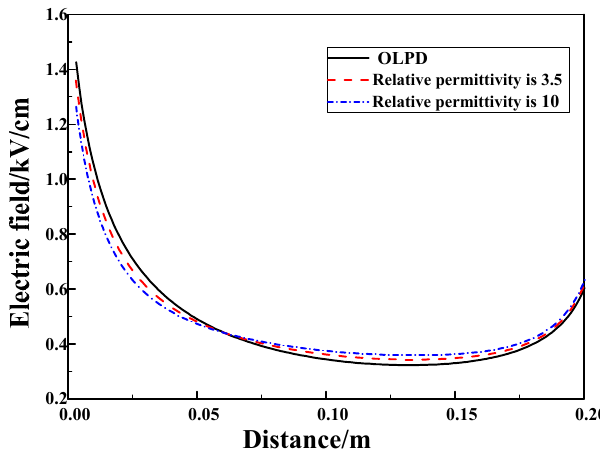
Figure 7. The results of electric field simulation.